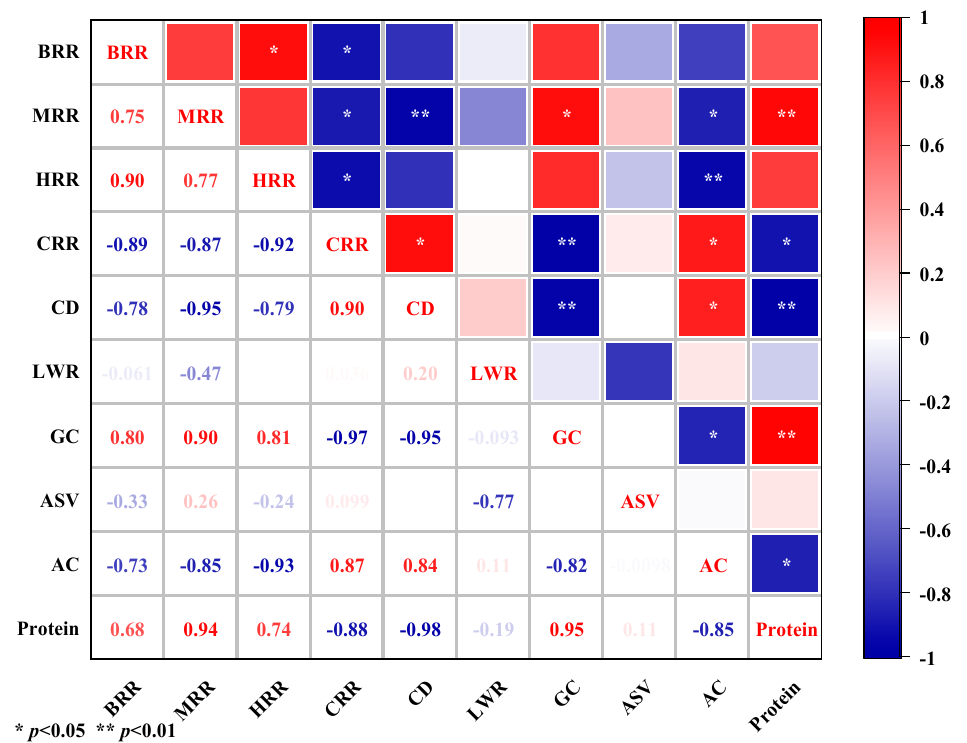
-0.6-0.4-0.200.20.40.60.81